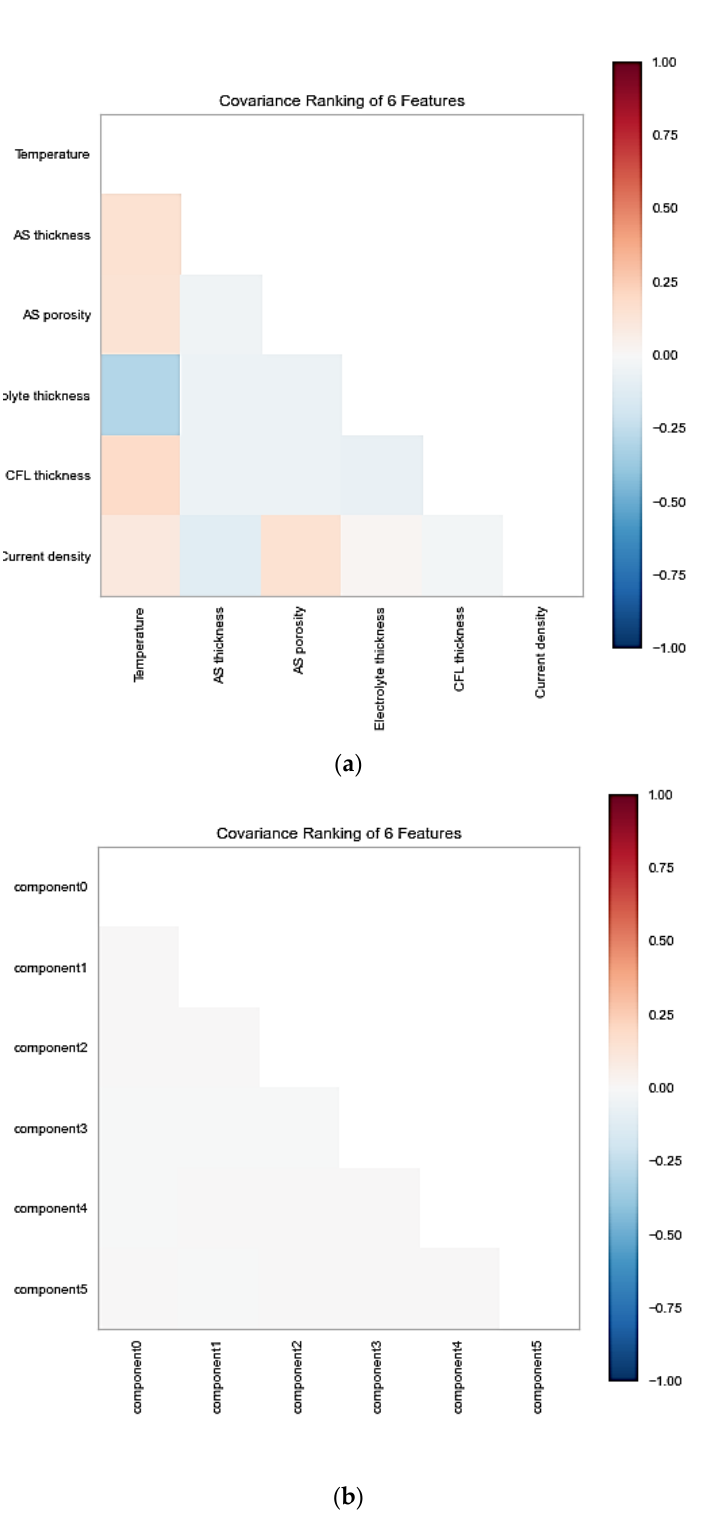
Figure 3. Covariance ranking of ( a ) standard original features and ( b ) decomposed features using